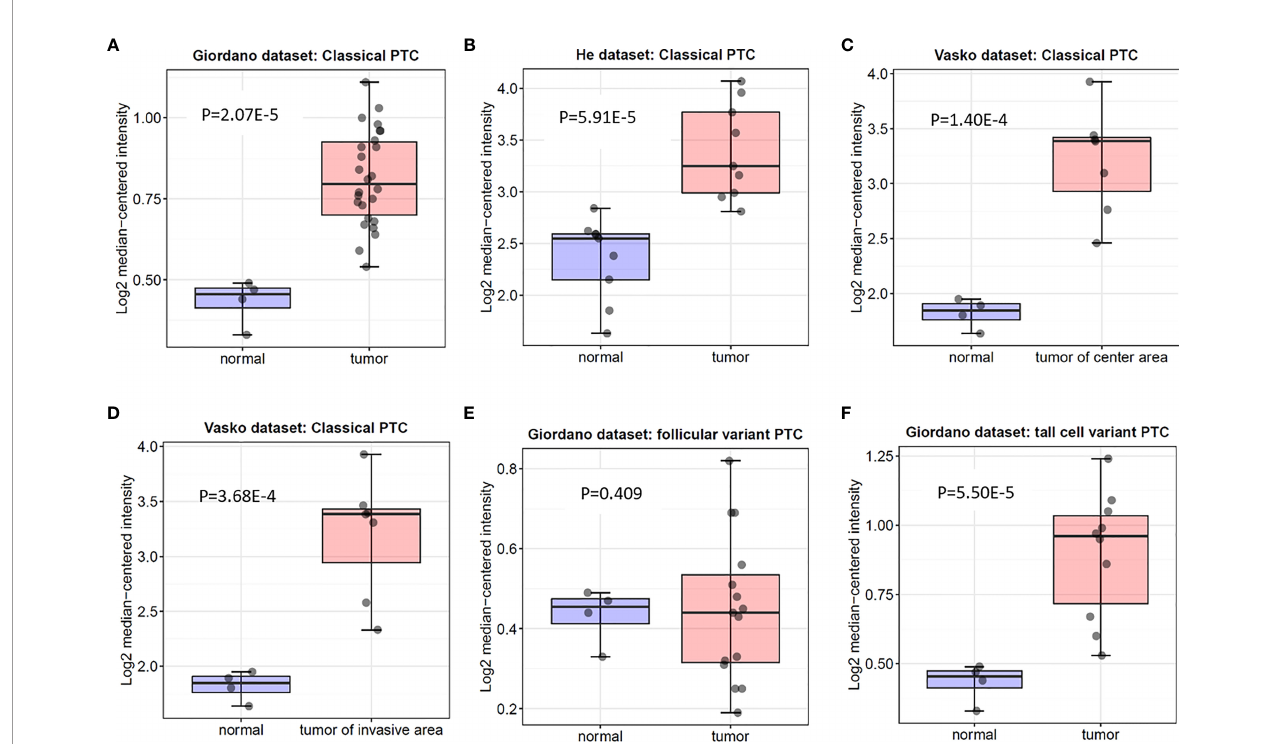
FIGURE 2 | Box plot of ITGA3 expression in normal thyroid gland and papillary thyroid cancer using the Oncomine database. P − values were calculated by Student ’ s t test. (A – D) The expression of ITGA3 in normal thyroid gland and classical papillary thyroid cancer. (E) The expression of ITGA3 in normal thyroid gland and follicular variant papillary thyroid cancer. (F) The expression of ITGA3 in normal thyroid gland and tall cell variant papillary thyroid cancer.